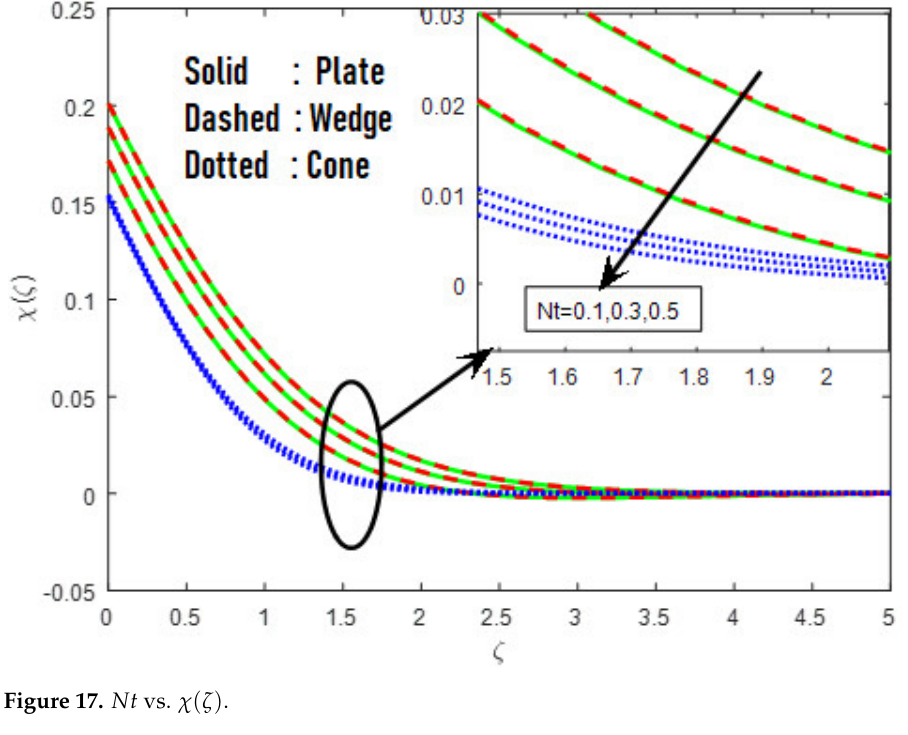
Nt vs. Figure 17. Nt vs. χ ( ζ ) . Figure 17. Figure 17. Nt vs.